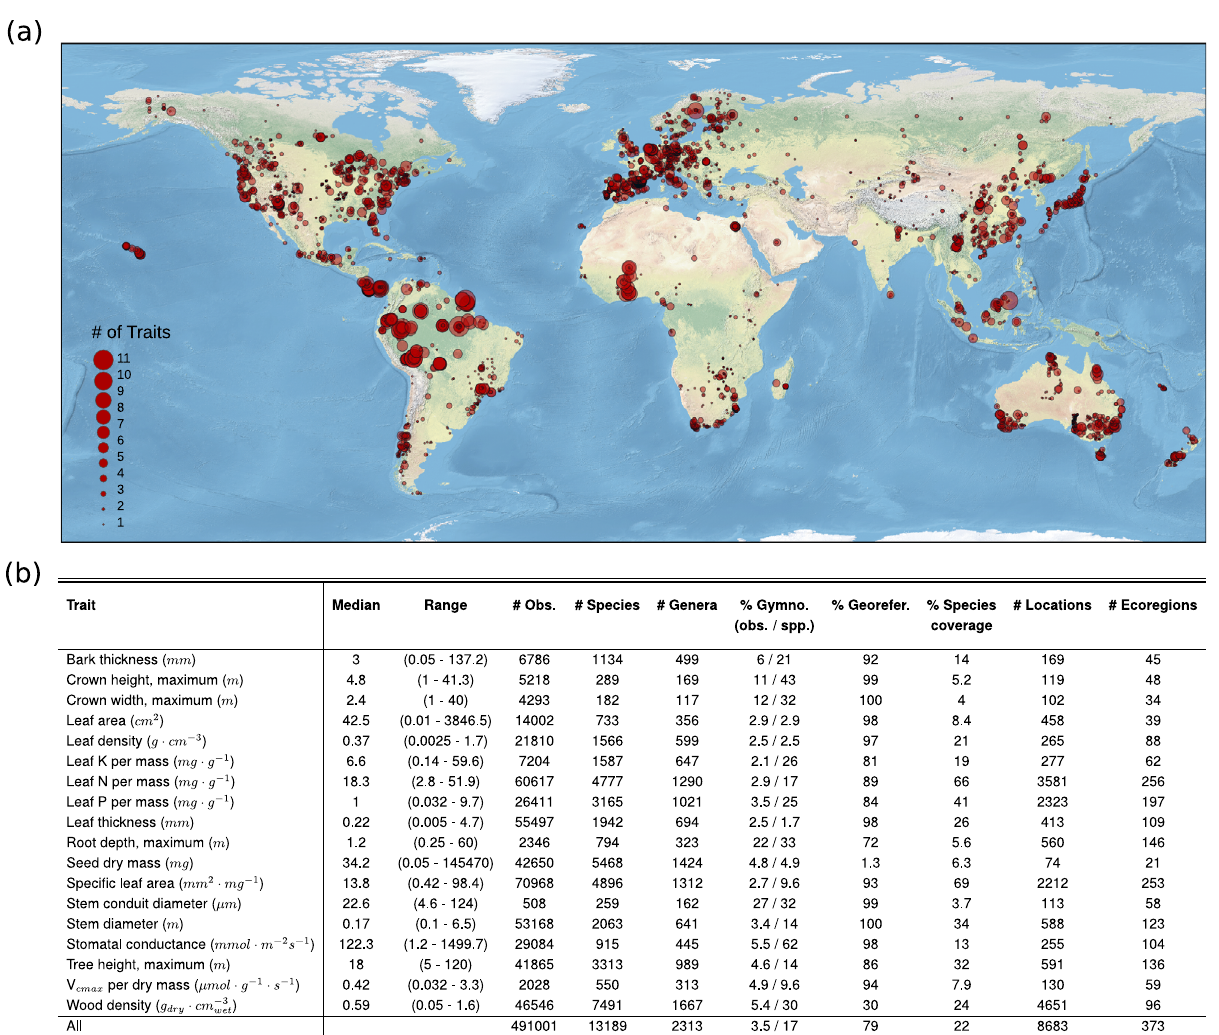
Fig. 1 Overview of the 18 functional traits. a The unique geographic locations ( n = 8683) where tree functional traits were recorded. The size of the circles denotes the relative number of unique traits (out of 18 possible) that were measured at each location, regardless of species identity. b Summary statistics for the 18 traits considered here (see Supplementary Table 1 – 3, Supplementary Figs. 1, 2 for additional information). The analysis included 491,001 trait measurements, encompassing 13,189 unique tree species and 2313 unique